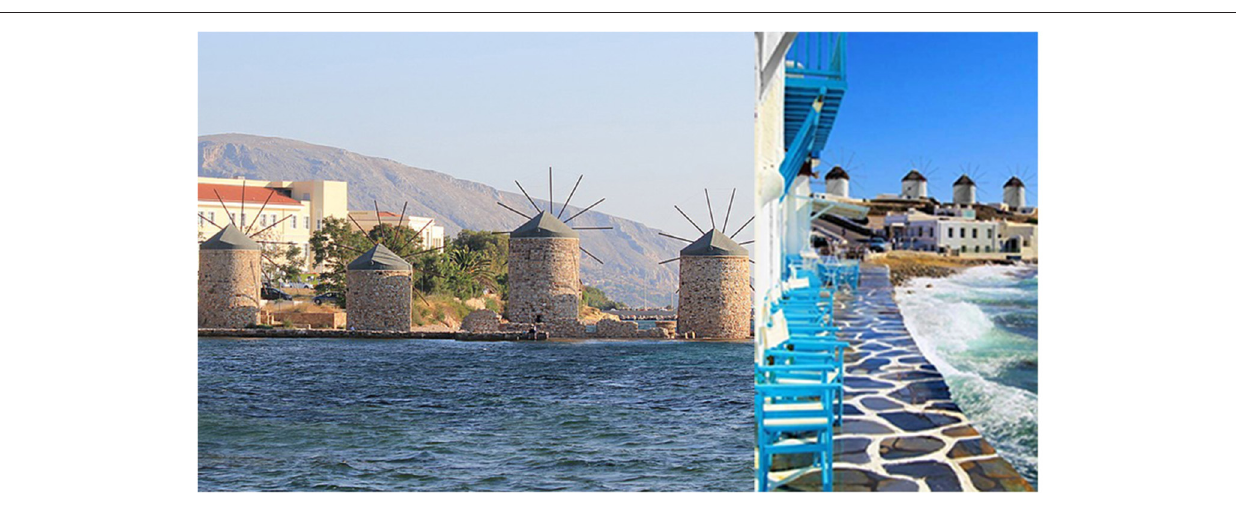
FIGURE 9 | Traditional wind energy installations as an inspiration for scale, sizing, distances of offshore wind farms located in significant for Greek culture and tourism areas (Images accessed July 30 2018). (Right) Little Venice, Mykonos https://commons.wikimedia.org/wiki/File:Mykonos,_little_venice_02.JPG Attribution: I, Sailko Creative Commons Attribution 2.5 Generic license. (Left) Chiod islands retrieved from https://www.maxpixel.net/static/photo/1x/Sea-Marina-Chios-Greece- Windmill-Ruins-Holidays-1711777.jpg CC0. Public